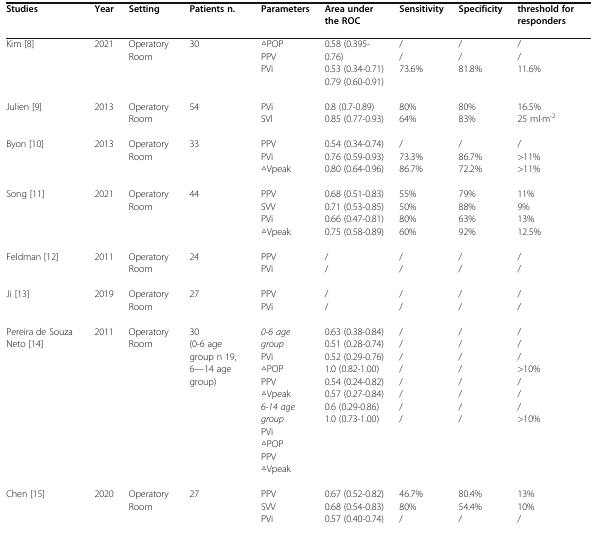
Table 1 (abstract A138). Parameters, area under receiver operating characteristic (ROC) curve, sensitivity, specificity and threshold